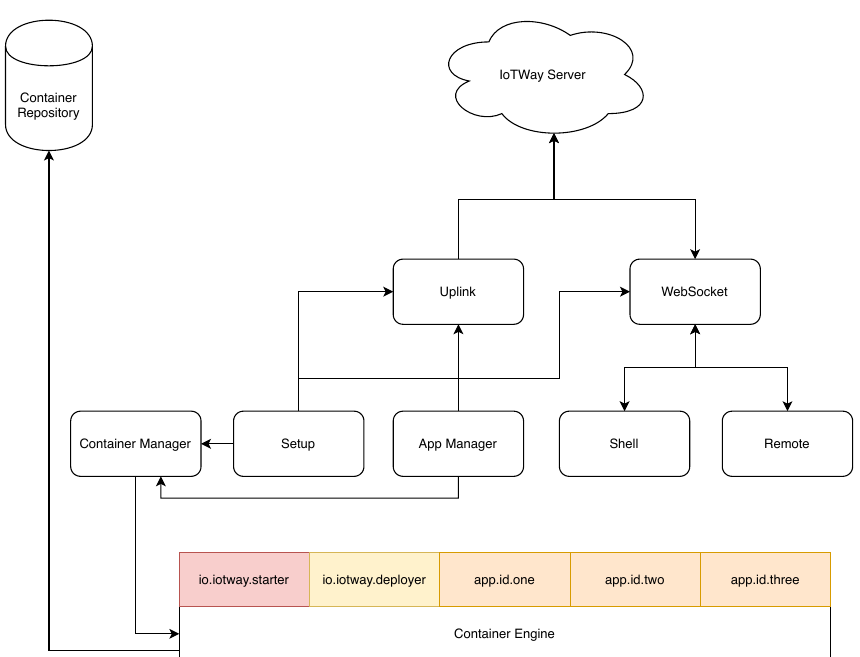
Figure 5. The IoTWay architecture components and how they